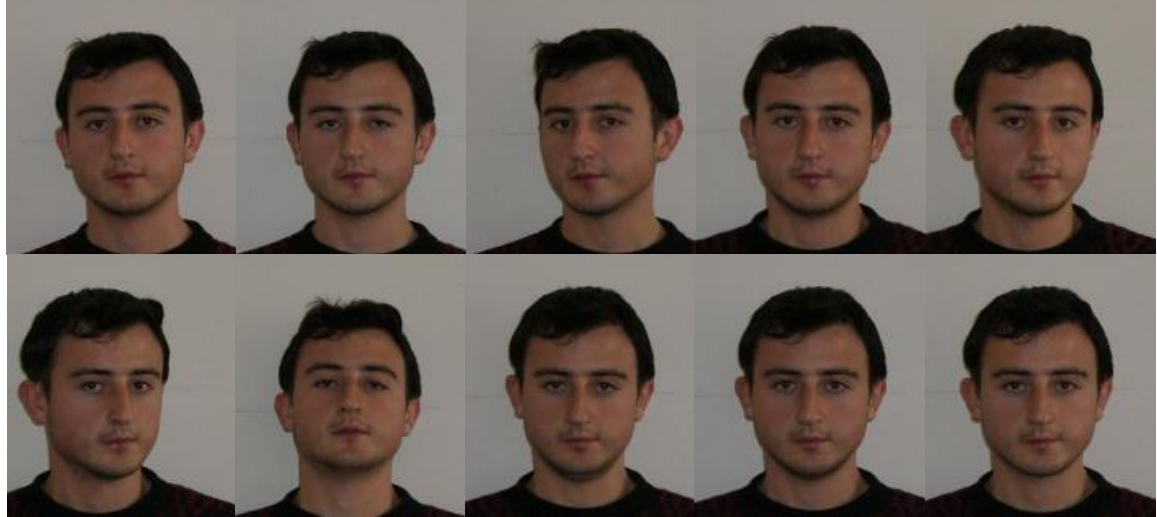
Figure 12. Face images captured from different angles from an